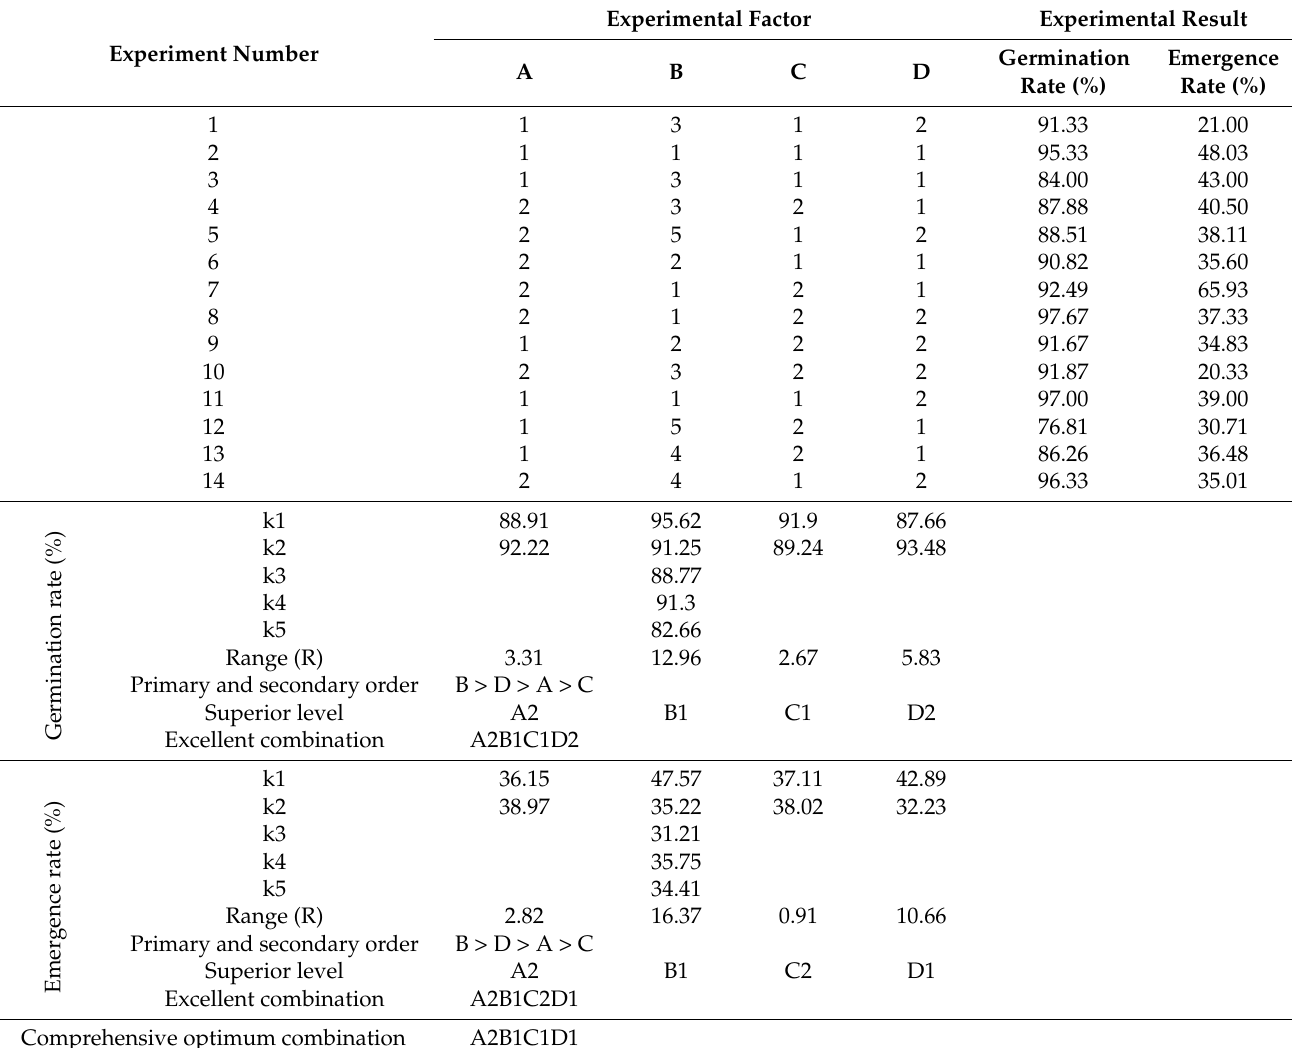
Table 2. Orthogonal experimental design and optimum results of Ecolly grape seeds.